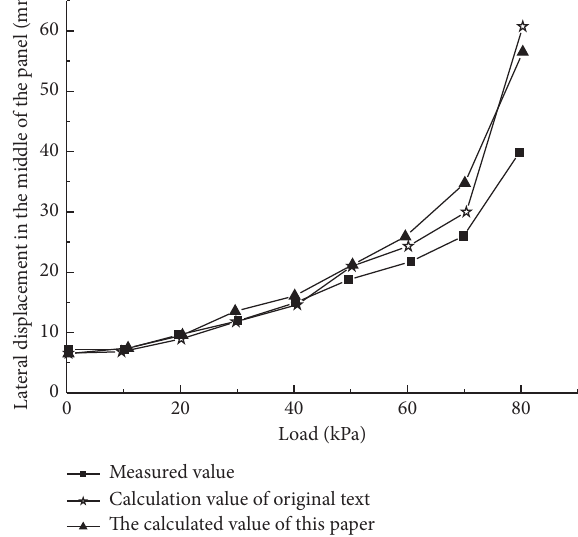
Figure 4: Comparison of the calculated and measured lateral displacement of the wall